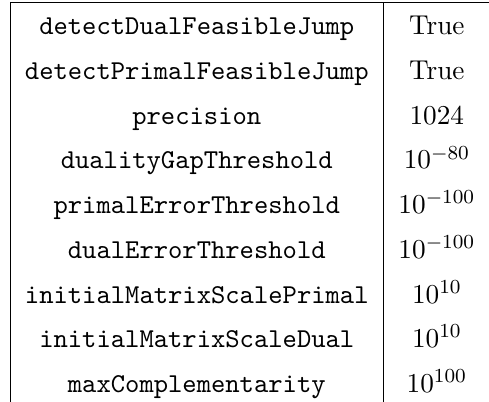
Table 1 . Our settings for SDPB version